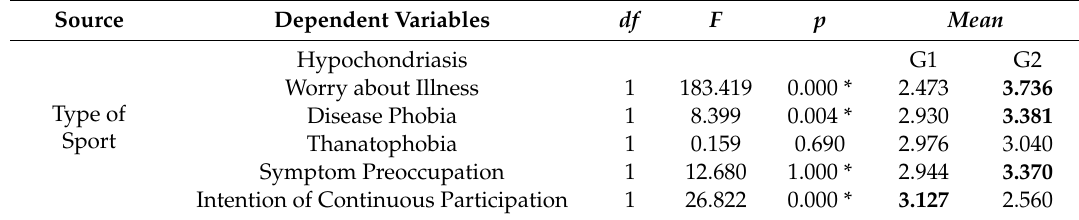
Table 5. Results of main e ff ect (type of sport) on dependent